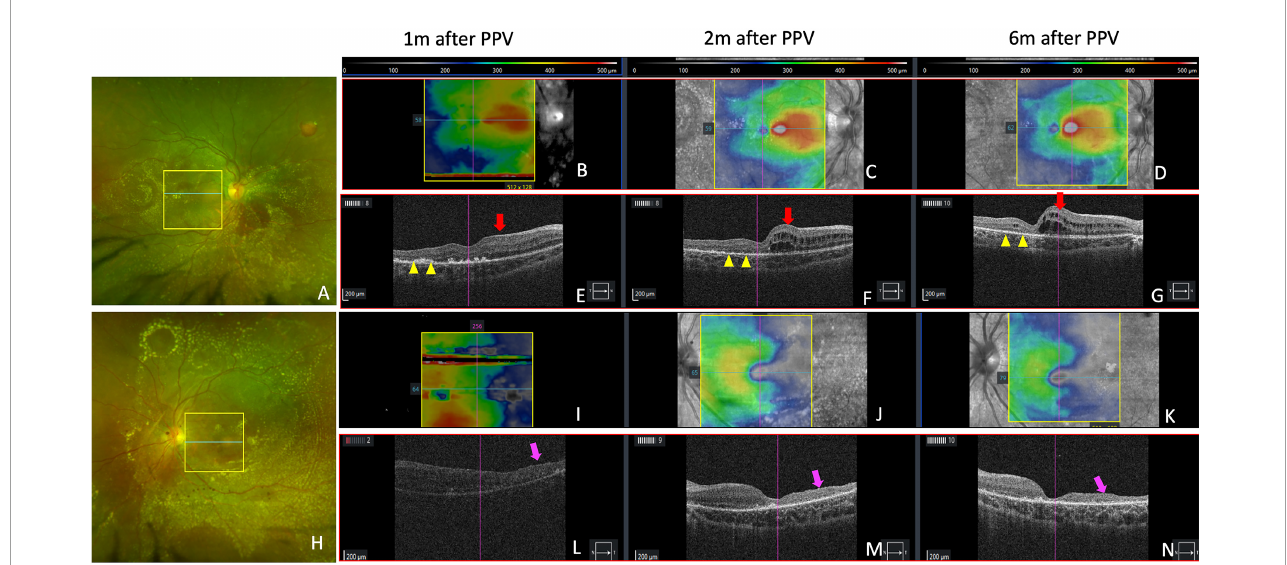
FIGURE3 Retinal and optical coherence tomography (OCT) images showing retinal changes after vitrectomy. (A,H) Show retinal imaging by scanning laser ophthalmoscopy at 2 months. Yellow boxes in (A,H) show the area of OCT scanning in (C,J) with bule lines indicating the location of B-scans in (F,M) . (B–D) Show retinal thickness maps of right eye at 1 month, 2 months, and 6 months after vitrectomy. The color bars are shown above the panels. (E–G) Show horizontal OCT B-scans in the macular fovea of right eye. Yellow arrow heads show where hard exudates in the macular gradually absorbed without damage to outer retina. (I–K) Show retinal thickness maps of left eye at 1 month, 2 months, and 6 months after vitrectomy. (L–N) Show horizontal OCT B-scans in macular fovea of left eye. Red arrows show nasal macular edema after vitrectomy. Purple arrows show temporal macular